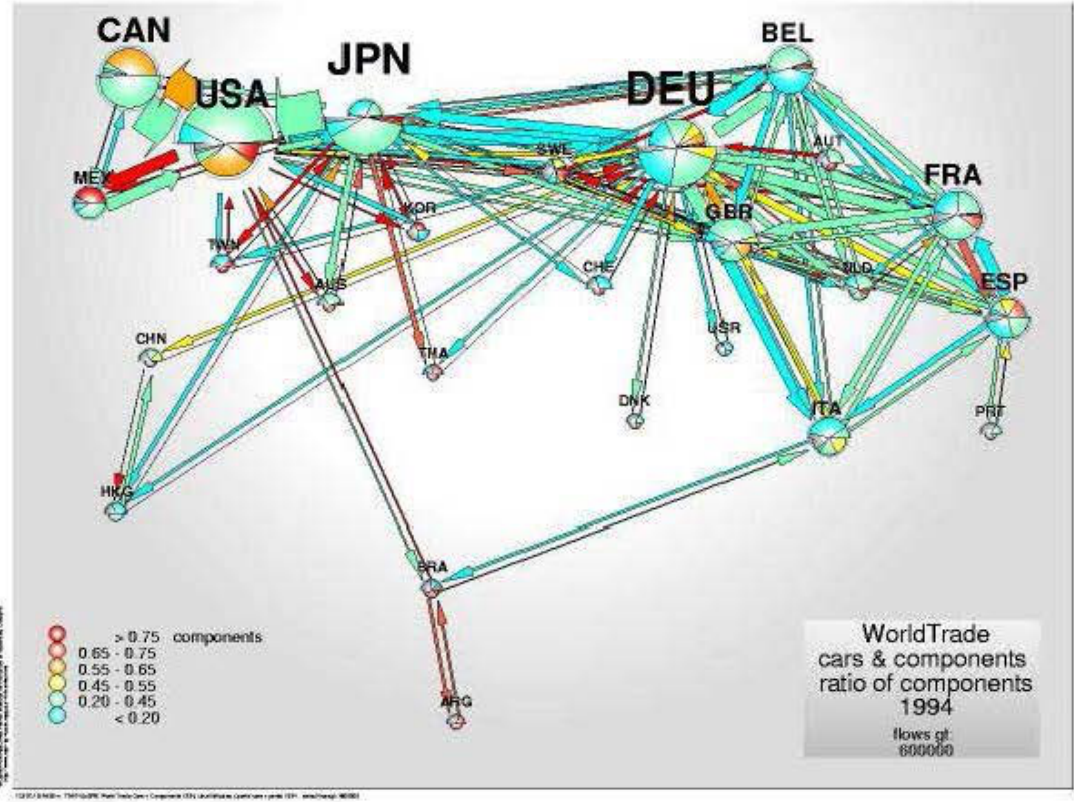
Figure 6: Shares of the Coinpon"-nt